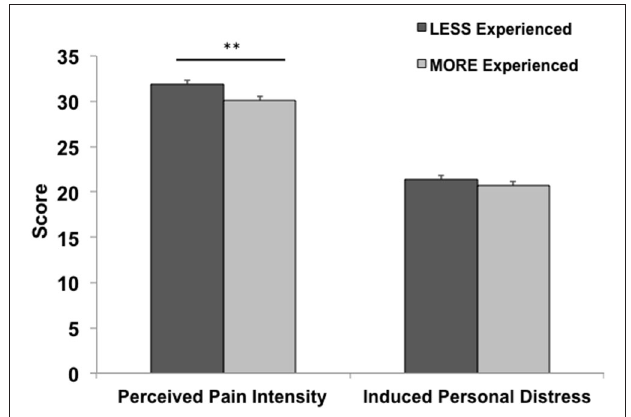
FIGURE 1 | The effect of professional medical experience . Mean ( S.E.M. ) for behavioral measures in less vs. more experienced physicians. More experienced physicians perceived significantly lower rates of pain (** p < 0.01). Error bars are S.E.M.